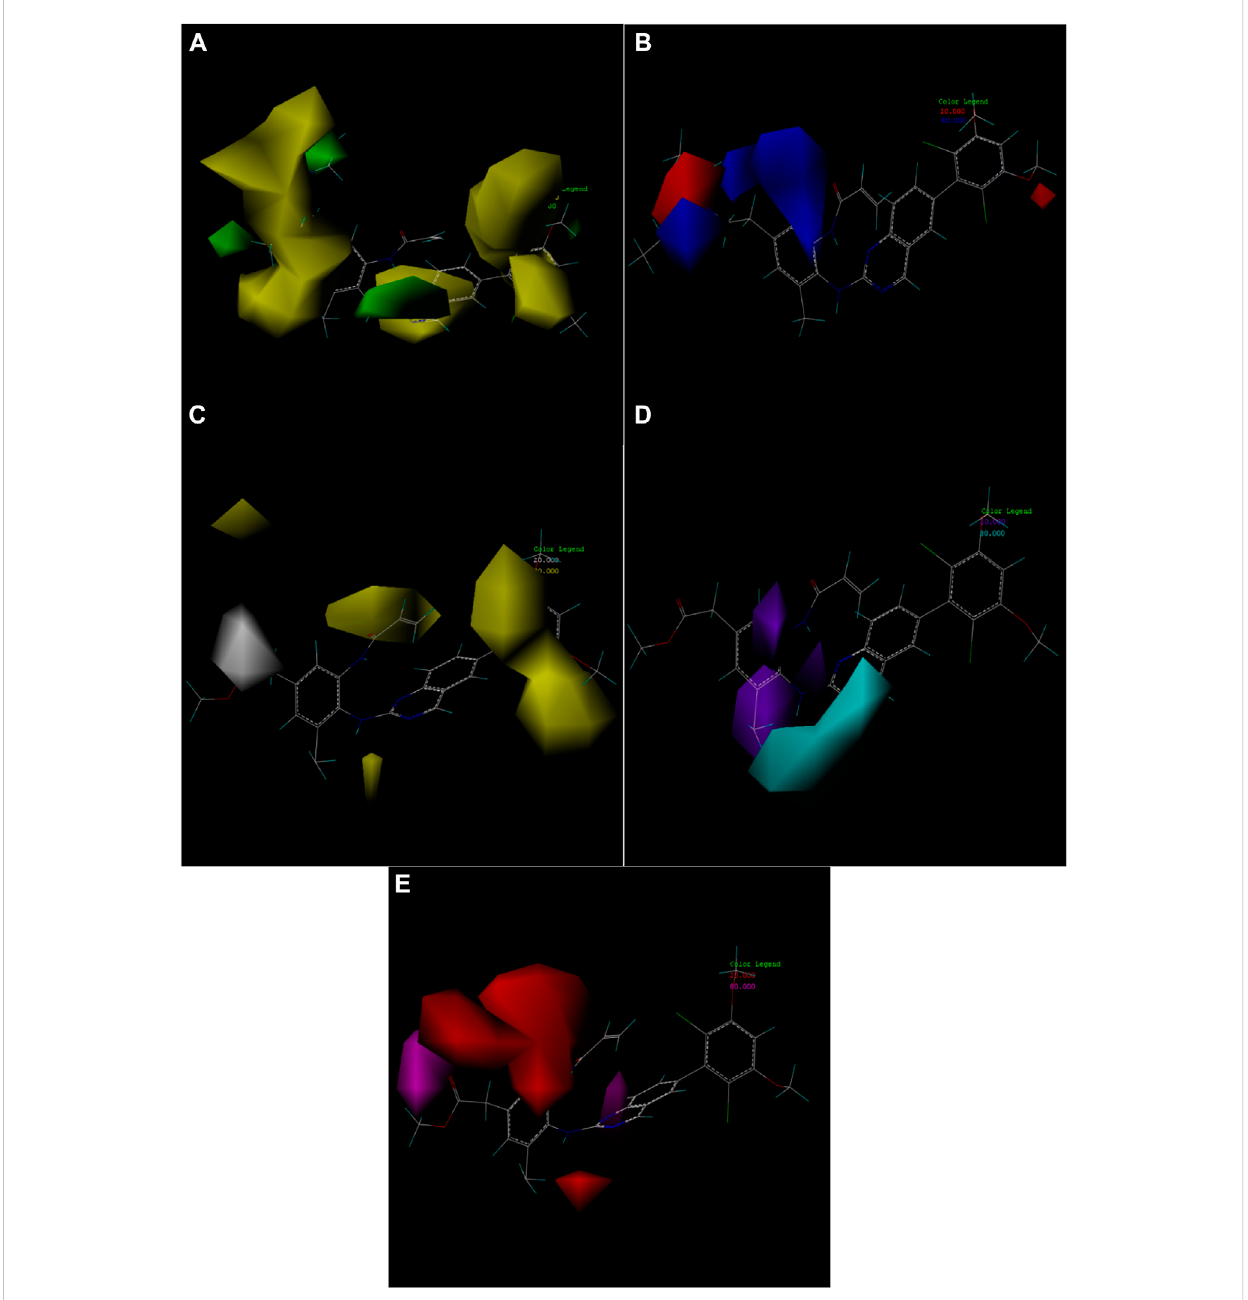
FIGURE 7 Contour map of optimal compound 19g. (A) In thesteric fi eld, greenrepresents favorable and yellow represents unfavorable. (B) In theelectrostatic fi eld,bluerepresentsapositiveelectric fi eldandredrepresentsanegativeelectric fi eld. (C) Inthehydrophobic fi eld,yellowrepresentsfavorableandwhite represents unfavorable. (D) Favorable (cyan) and unfavorable (purple) hydrogen bond donor fi elds. (E) Favorable (magenta) and unfavorable (red) hydrogen bond acceptor fi